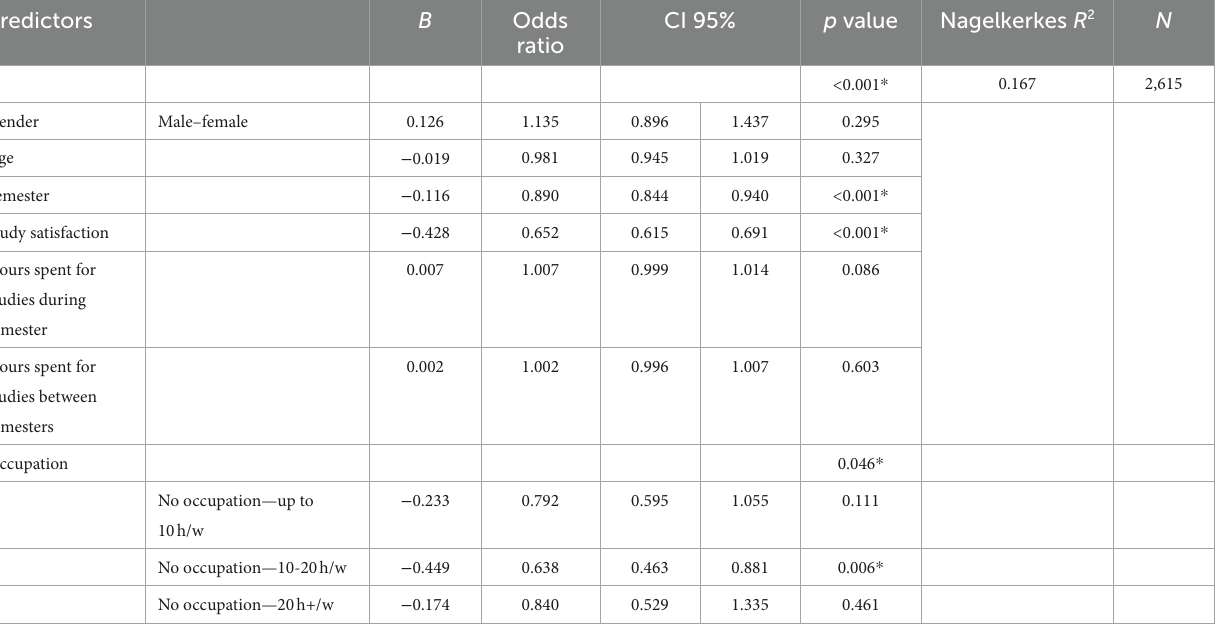
TABLE 6 Binary regression model for reduced academic